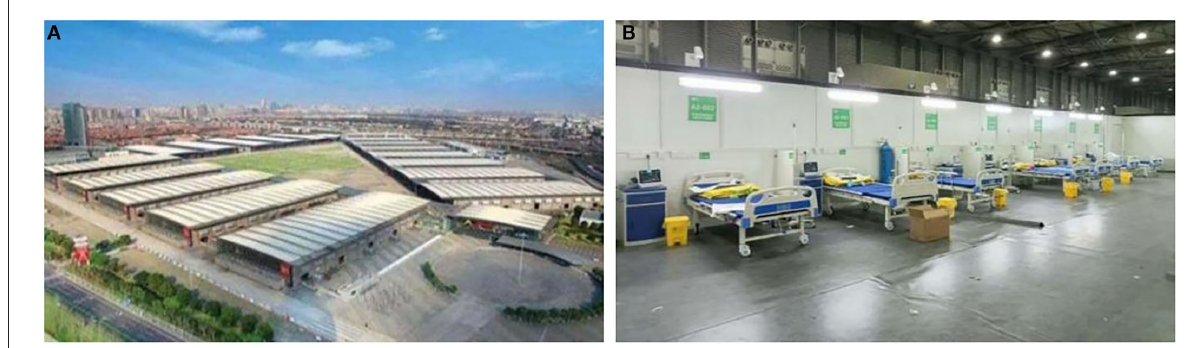
FIGURE1 Exterior birdview (A) and interior view in subordinate cabin (B) of the SNIEC makeshift